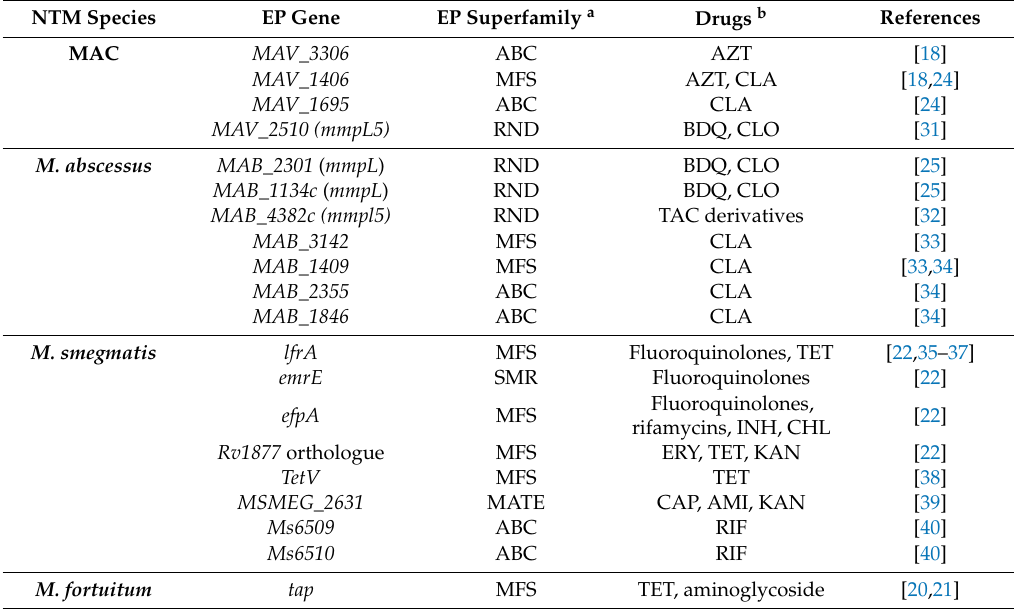
Table 1. Major nontuberculous mycobacteria (NTM) e ffl ux pumps (EPs) associated with drug resistance.